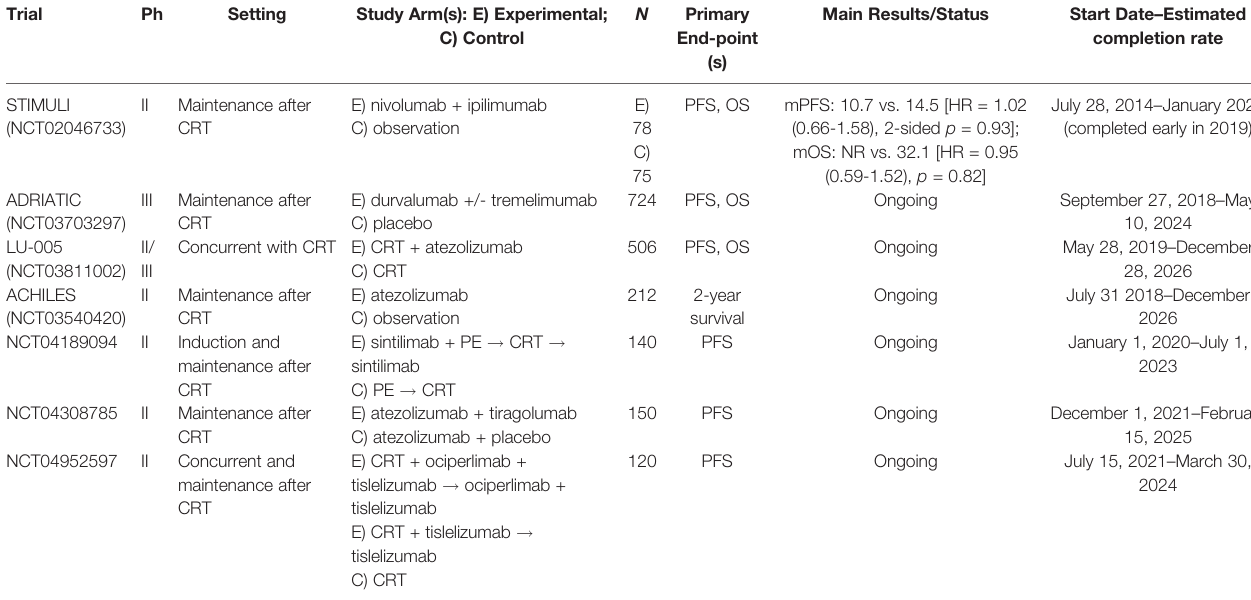
TABLE 1 | Selected randomized clinical trial testing immunotherapy in SCLC limited disease. Trial Ph